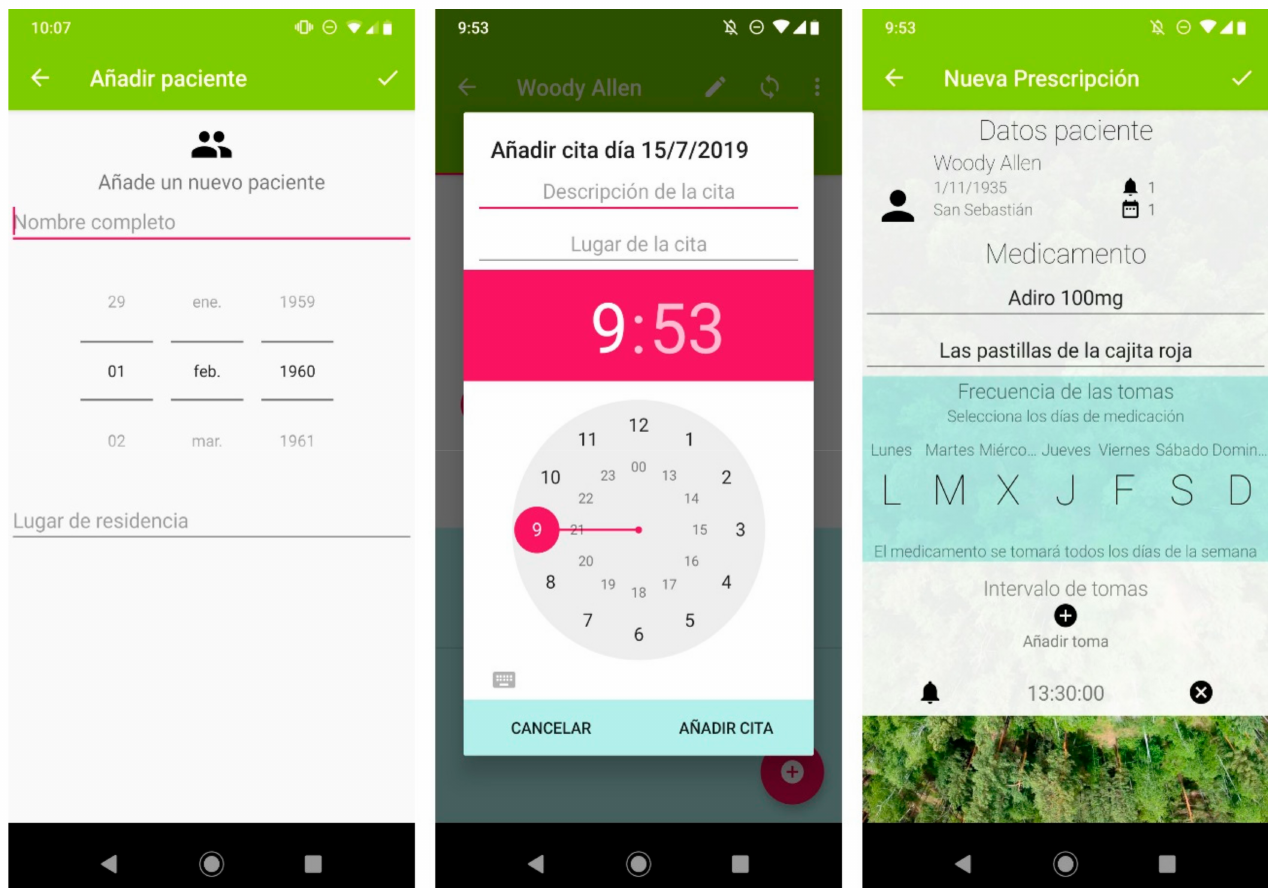
Figure 1. A selection of screenshots from the app. The application allows information on multiple patients to be stored ( left panel ). It includes a calendar ( central panel ) where the date, time, location and description of the next medical appointment can be specified. The pharmacological reminder function ( right panel ) allows the health professional to specify the name of the medicine, a brief personalized description of it, the days on which it is to be taken, and at which times. The application includes a synchronization button for the encrypted transmission of the data to the voice assistant via